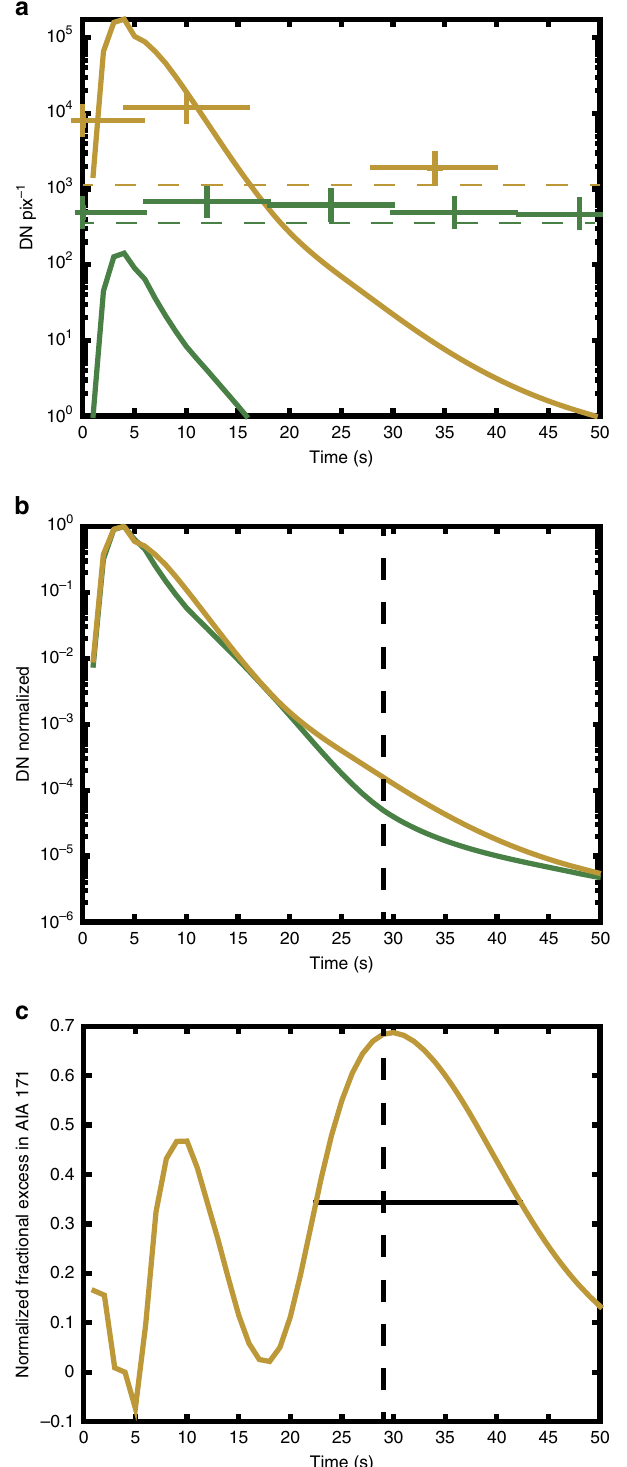
Figure 7 | Simulated and observed AIA light curves. ( a ) The simulated light curves in the AIA 94Å (green line) and 171Å (yellow line) channels for contributions from the flaring corona, transition region and chromosphere. The simulation does not include background from the overlying upper crosses) and 171Å (yellow crosses) channels including this background are shown. ( b ) The simulated profiles of the signals in AIA 94Å (green line) and 171Å (yellow line) above background. These profiles have been normalized to 1 at their peak values. The AIA 171Å channel is particularly bright compared to the AIA 94Å channel at around 30s. ( c ) The normalized fractional excess in AIA 171Å. The normalized light curves in panel b were subtracted to find the relative excess in the 171Å channel. This excess is plotted as a fraction of the emission in the 171Å channel at each instant. The full width half maximum (Horizontal black bar) indicates the times at which the jet is particularly bright in AIA 171Å compared to AIA 94Å, the vertical bar represents the maximum relative brightness at around